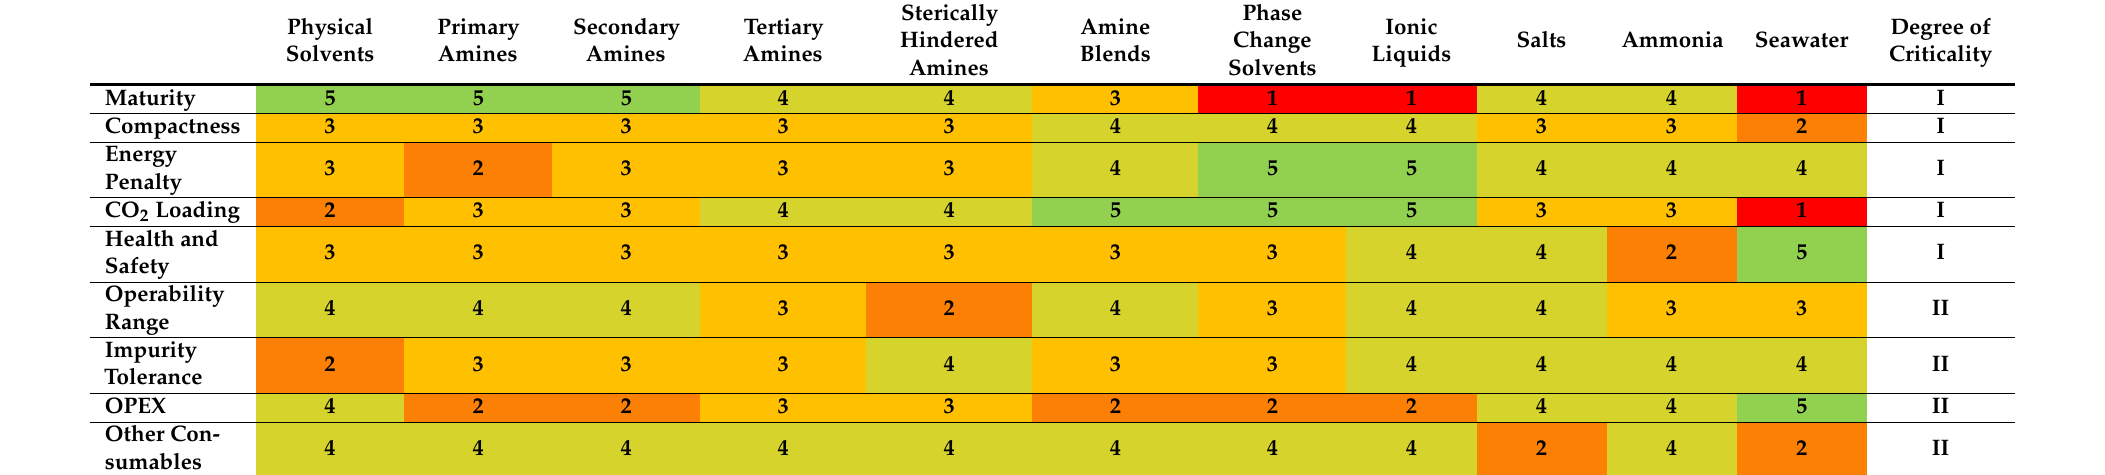
Table 3. Comparative assessment of the different solvent classes for CO 2 capture using on board KPIs